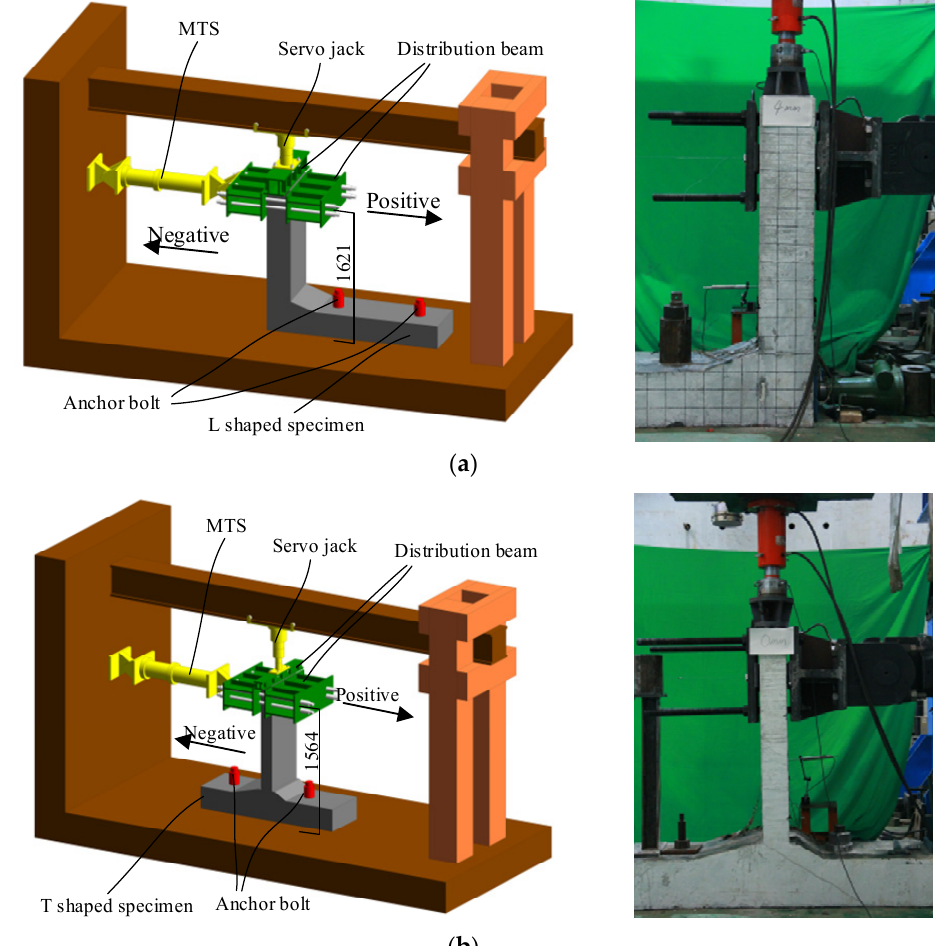
Figure 6. Diagram of the loading device. ( a ) L-shaped specimen; ( b ) T-shaped specimen.